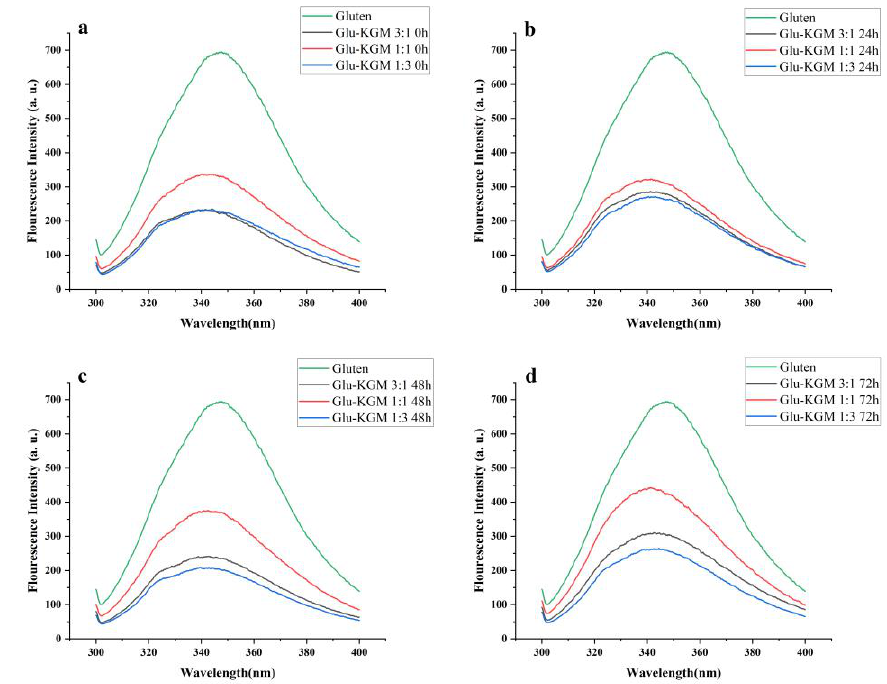
Figure 6. Intrinsic fluorescence spectra of gluten, mixtures, and conjugates, respectively. ( a ) Glu-KGM